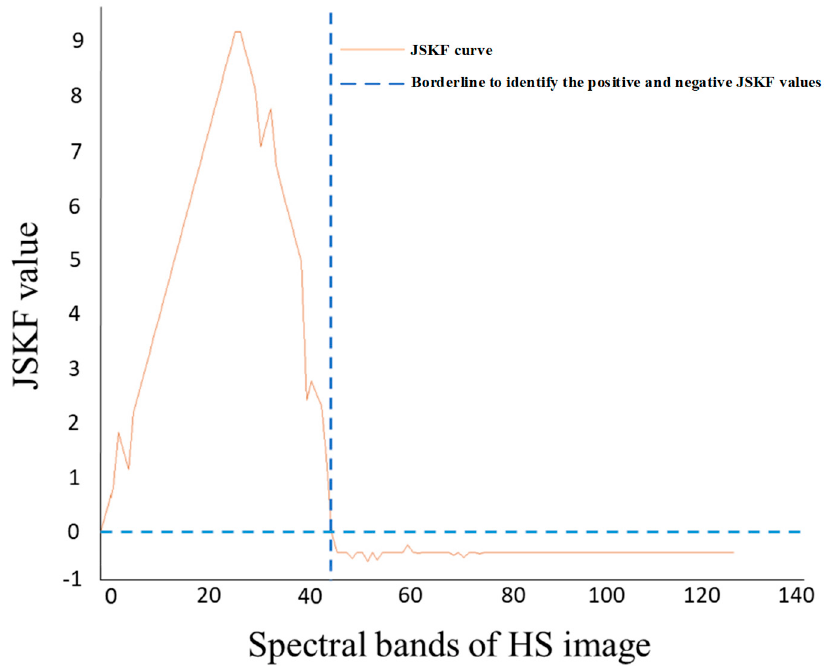
Figure 3. The JSKF curve of the original HS image.